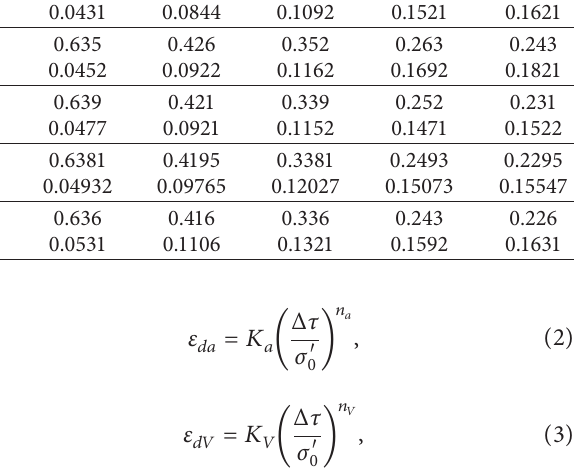
Table 3: Ratio of dynamic shear modulus ( G / G Rock-filled material